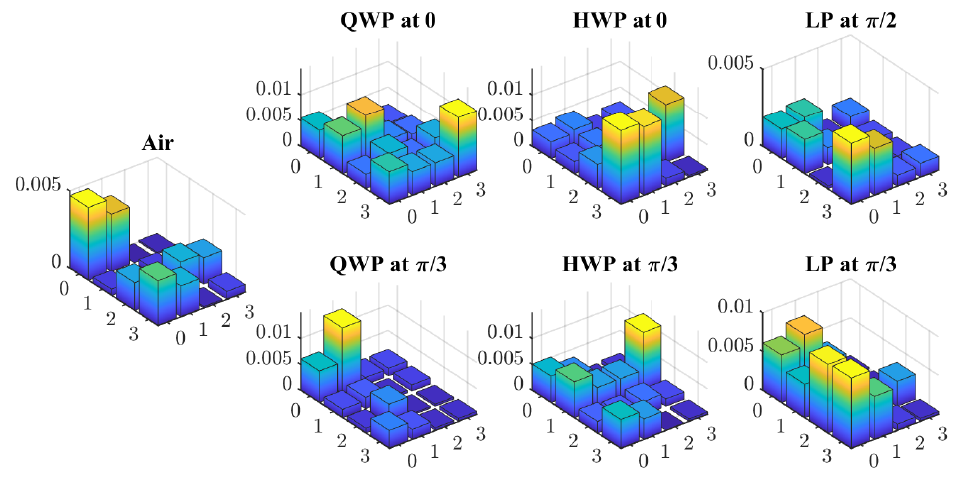
Figure 6. Absolute value of the difference of the experimental Mueller matrix and the theoretical one for each studied